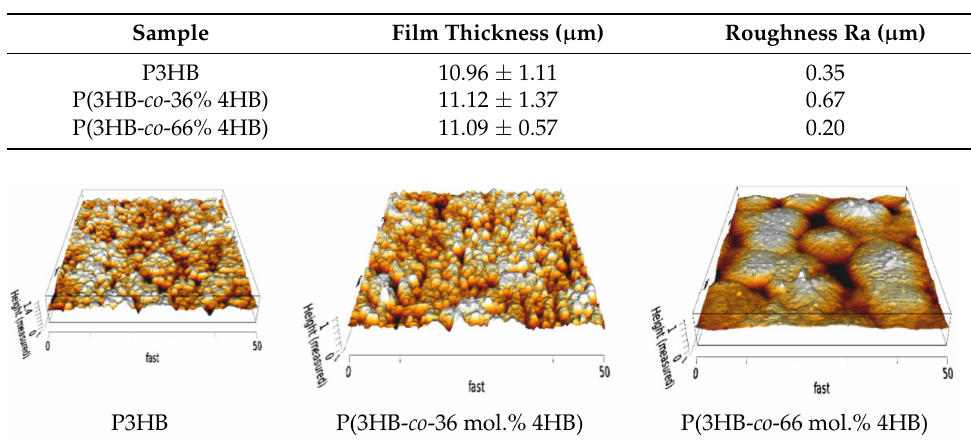
Table 2. Data from mechanic profilometry.